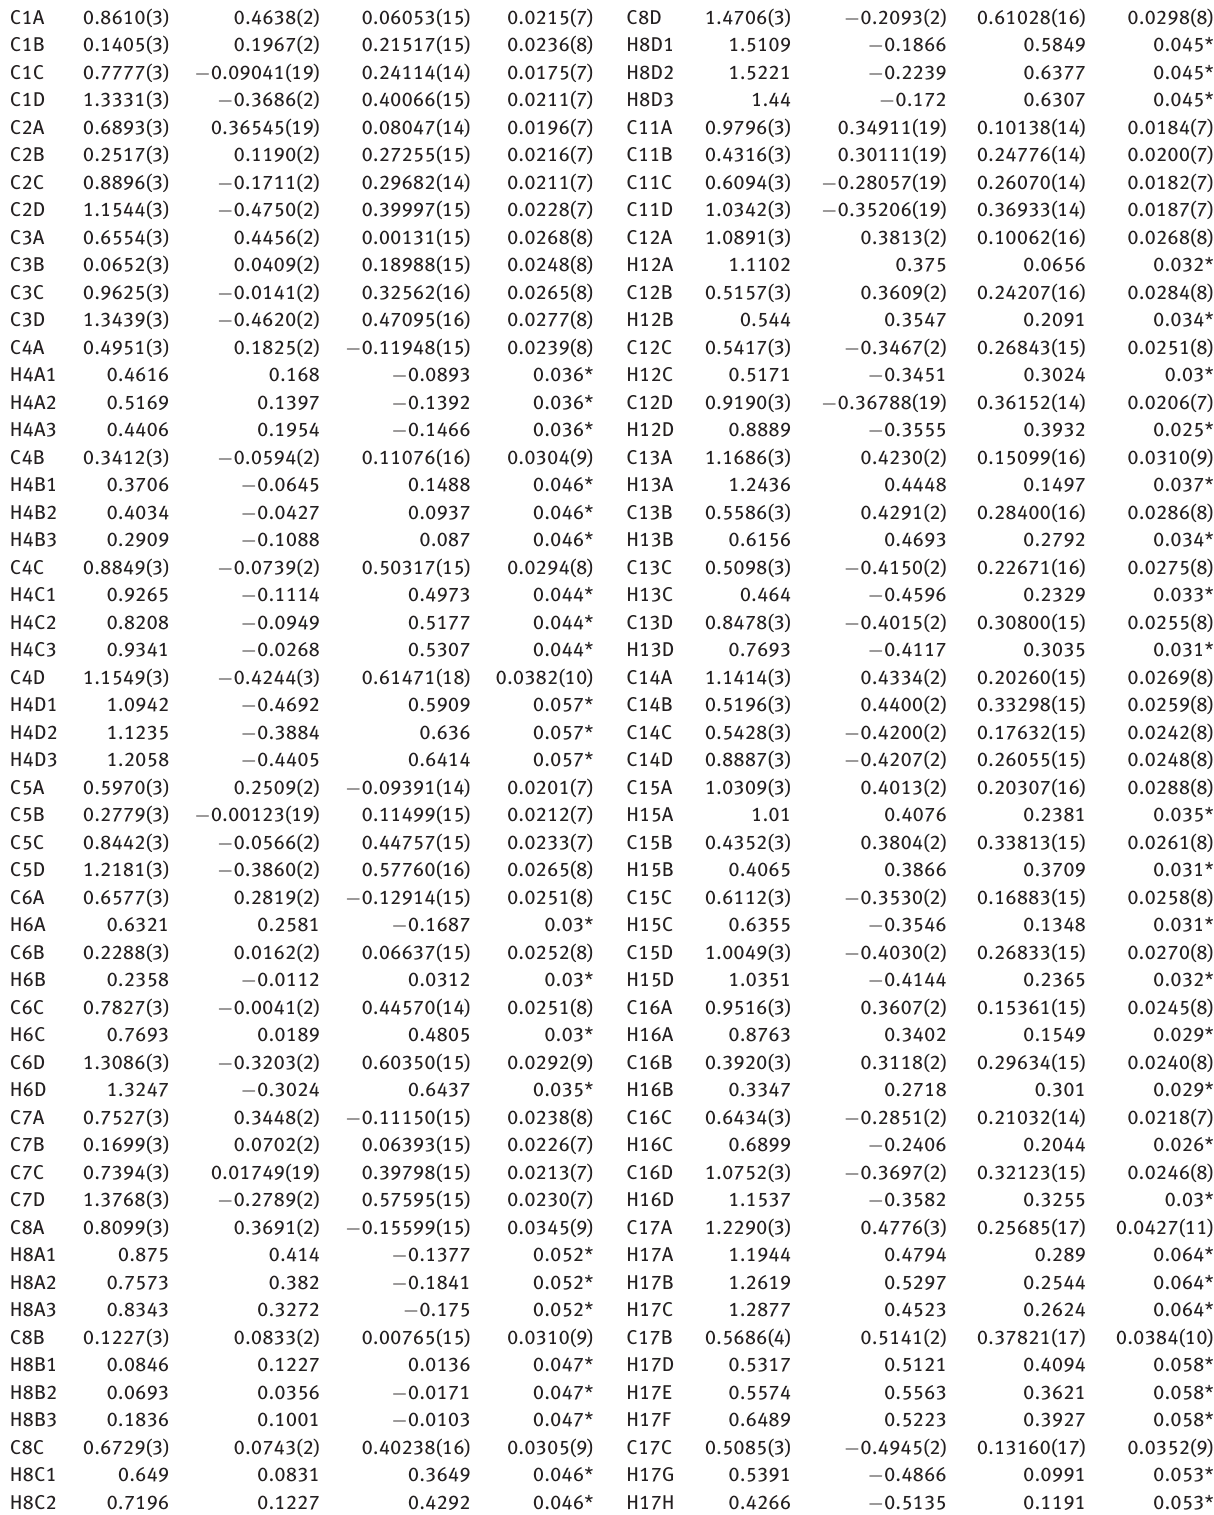
Table 2: Fractional atomic coordinates and isotropic or equivalent isotropic displacement parameters (Å 2